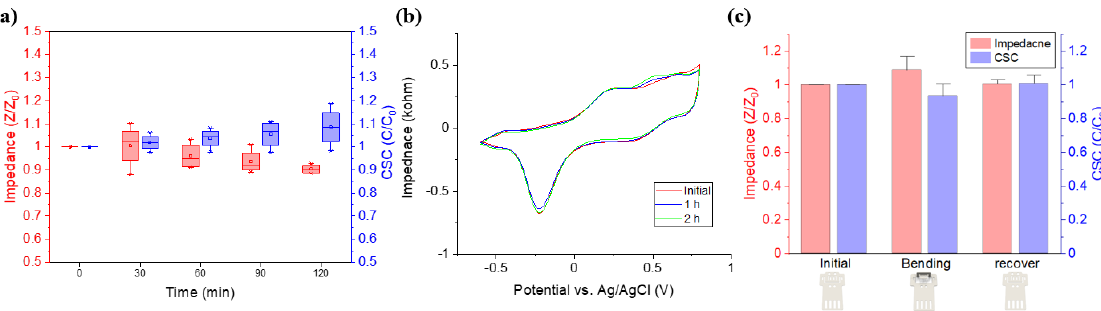
Figure 4. Stability test of the DCNI: ( a ) Impedance and CSC change according to volage application time (n = 4); ( b ) CV curve according to volage application time; and ( c ) Stability of the bending process (n = 4).